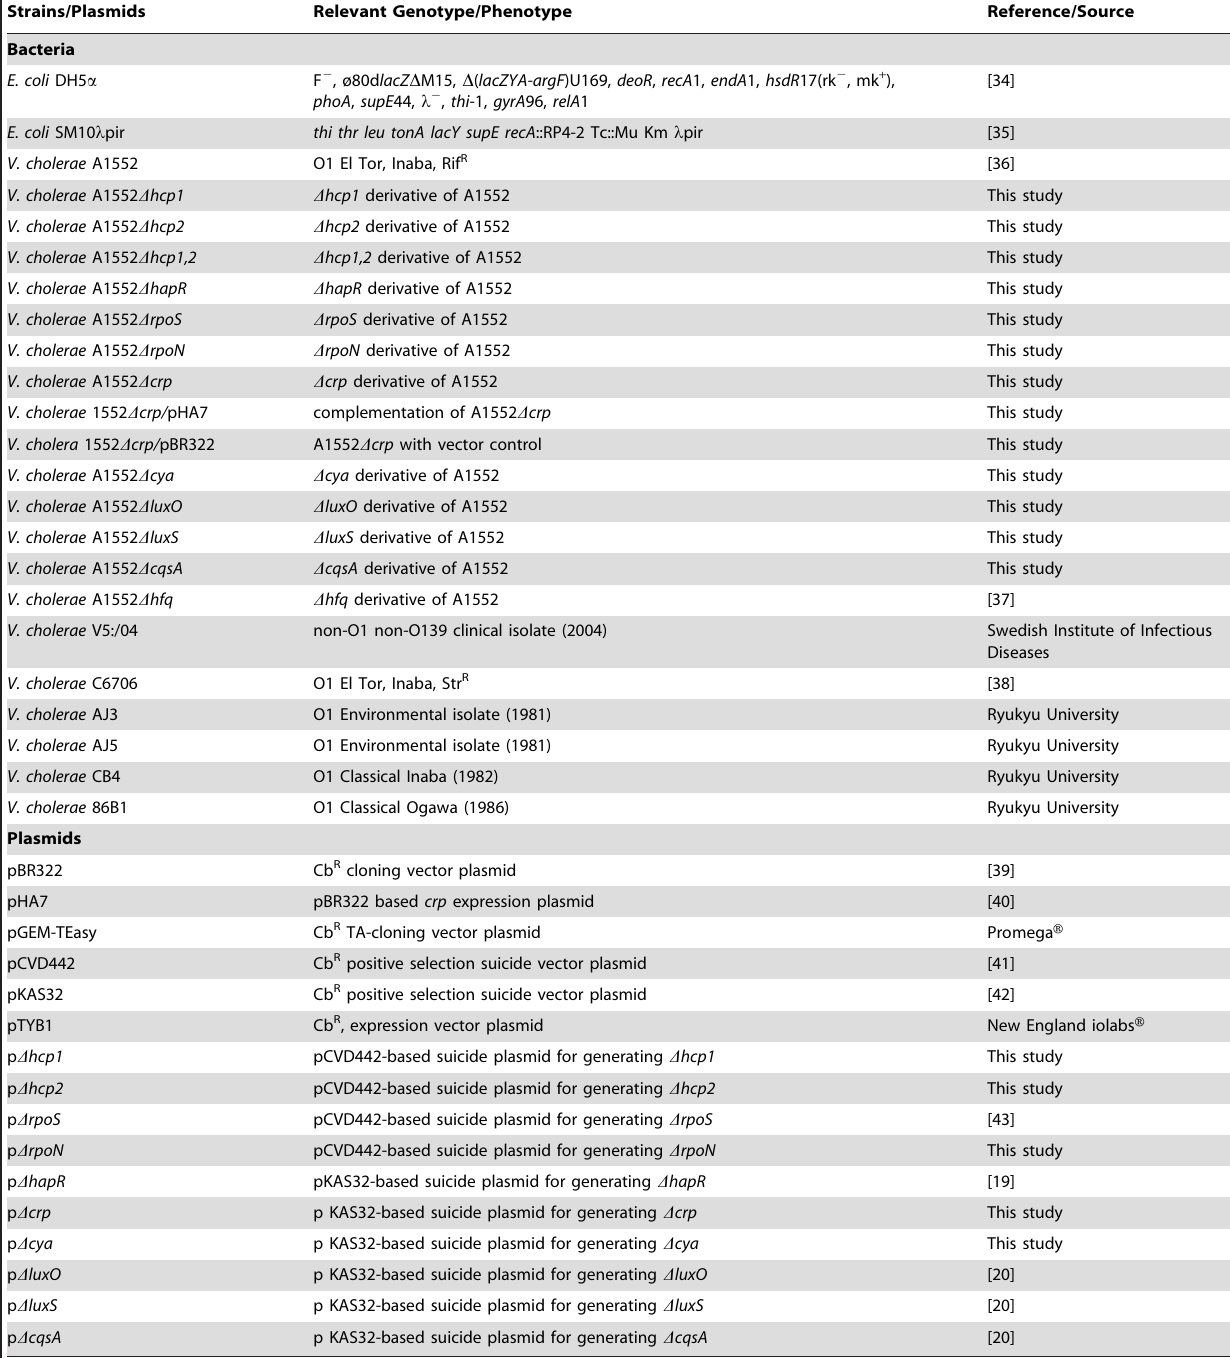
Table 1. Bacterial strains and